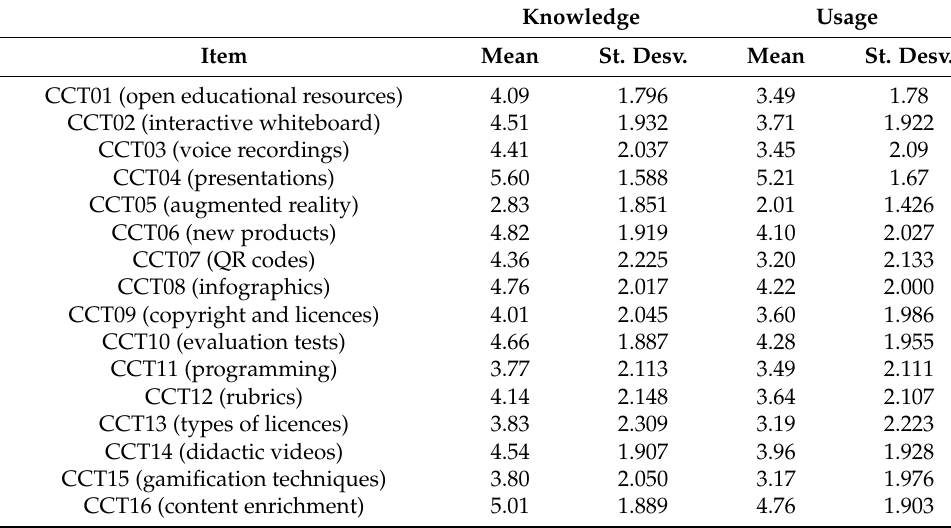
Table 7. Content creation tools